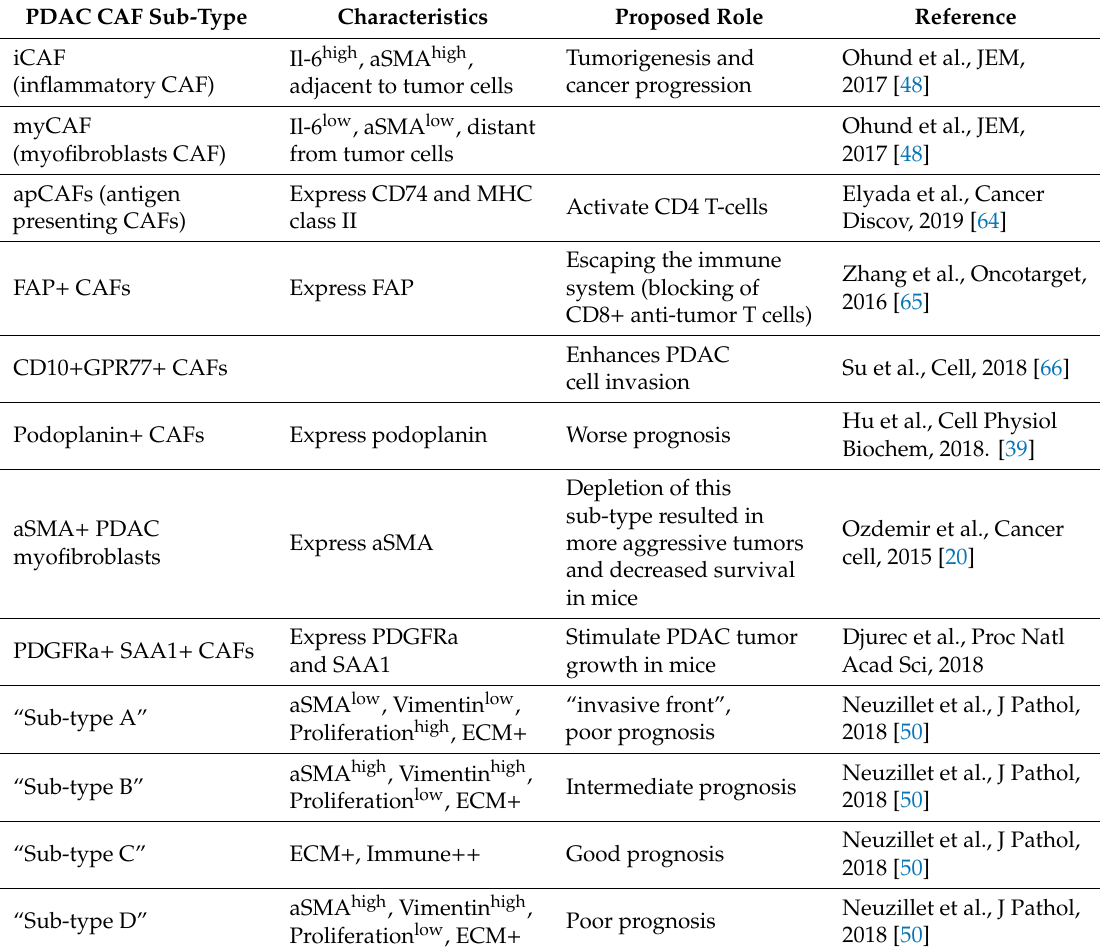
Table 2. Primarily pancreatic ductal adenocarcinoma (PDAC) CAF subtypes and their characteristic markers and